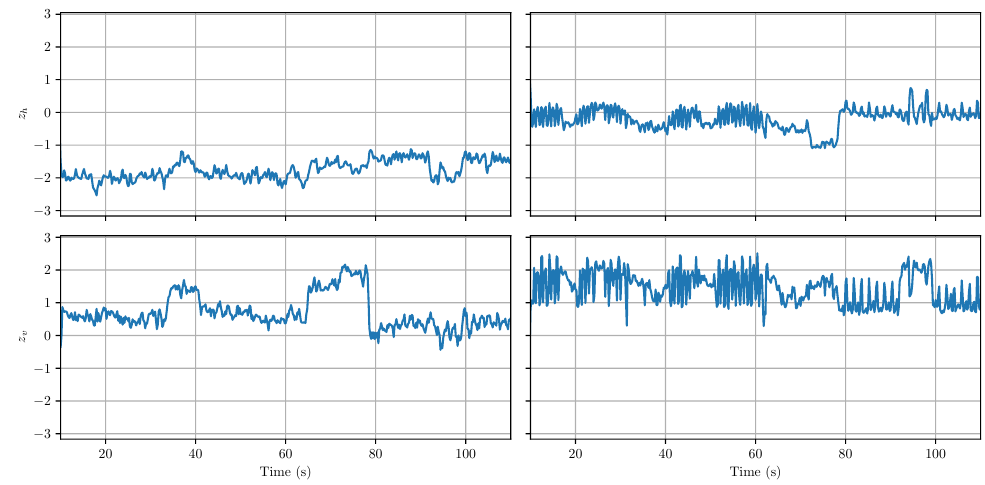
Figure 7. Horizonal ( top row ) and vertical ( bottom row ) components of the two-dimensional (2D) latent space trajectories for an excerpt of the song Date with the night by Yeah Yeah Yeahs (2003, Polydor). The columns show the trajectories of the models trained with cross-reconstruction loss ( left column ), and regular reconstruction loss ( right column